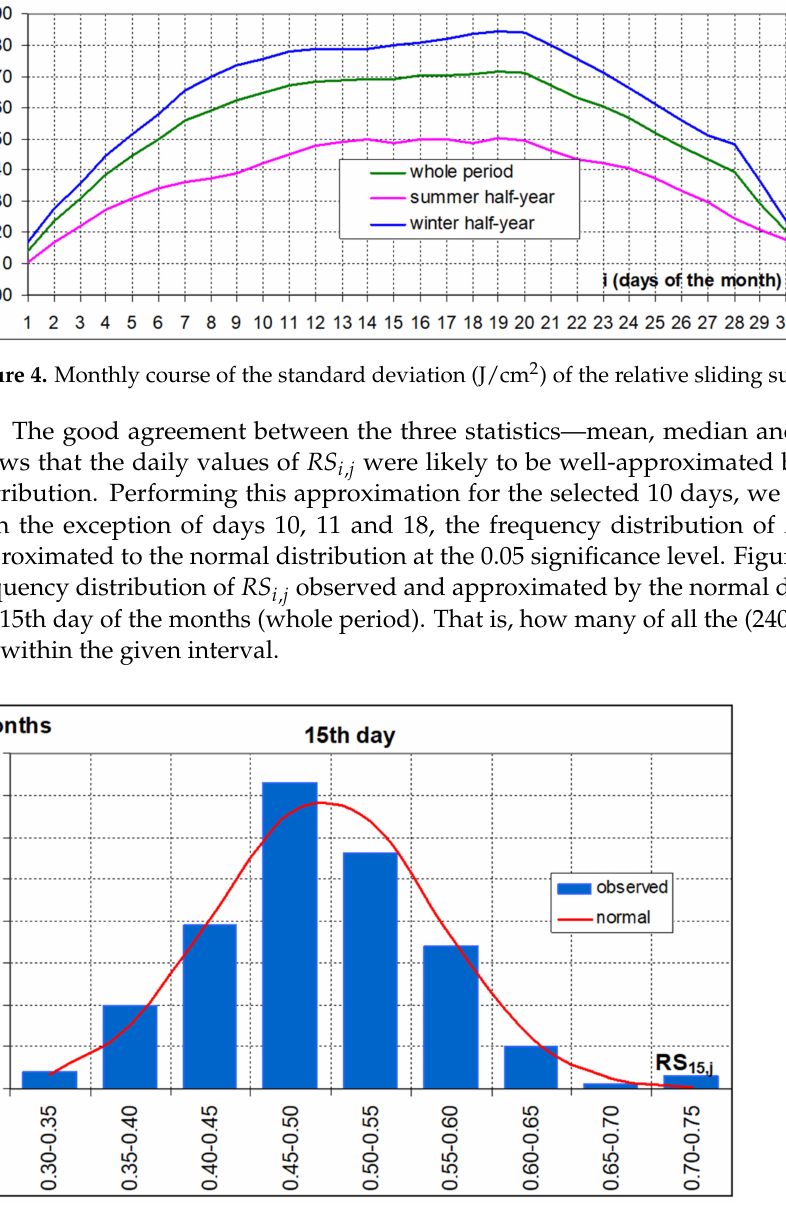
Figure 5. Approximation of the distribution of relative sliding sums ( RS 15, j ) calculated on the 15th day of the months with the normal distribution over the whole